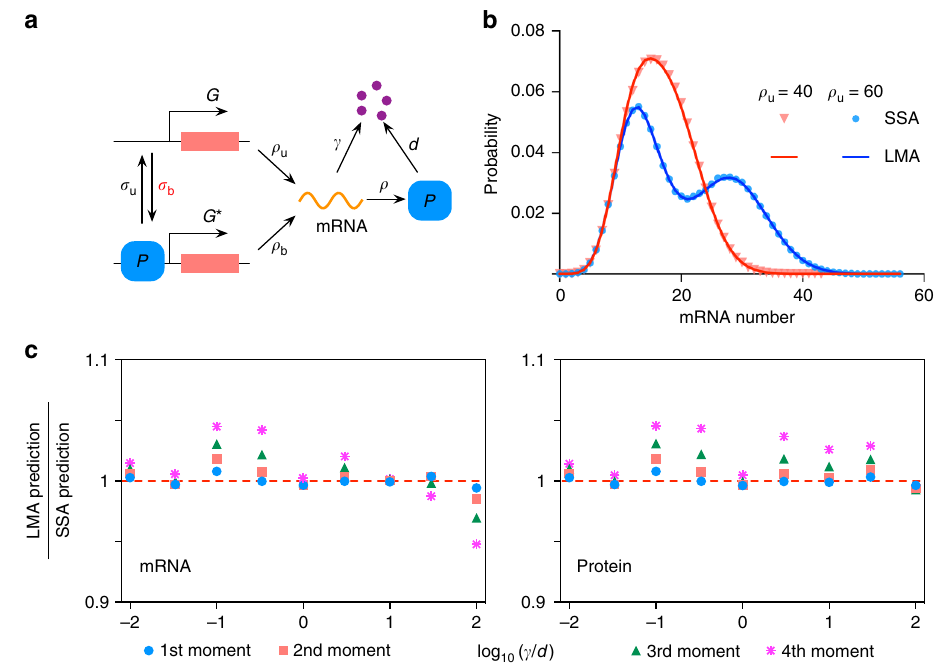
Fig. 6 LMA for the feedback loop with explicit modeling of both mRNA transcription and protein translation. a Illustrates the nonlinear feedback loop. b Shows the LMA and SSA predictions for steady-state mRNA distribution (See Supplementary Note 7), showing that the LMA is able to capture the change in modality induced by a change in ρ u . The rest of the parameters are: ρ b = 25, σ b = 0.004, σ u = 0.25, ρ = 3, γ = 2 and d = 1. c Compares LMA and SSA predictions for the fi rst to fourth moments (about zero) of both mRNA and protein numbers over a wide range of the mRNA-protein degradation ratio γ / d . The result indicates that the accuracy of the LMA is independent of time-scale separation assumptions. The parameters used are: ρ u = 5, ρ b = 0, = 1, σ = 1.5 × 10 − 5 . The nine pairs of ( γ , d ) are: (0.02, 2), (0.02, 0.6), (0.05, 0.5), (0.05, 0.15), (0.2, 0.2), (0.15, 0.05), (0.2, 0.02), (0.15, ρ = 100, σ u b 0.005) and (0.2, 0.002), constituting a logarithmic span from − 2 to 2. The ratio γ / d varies over a range consistent with mammalian gene expression